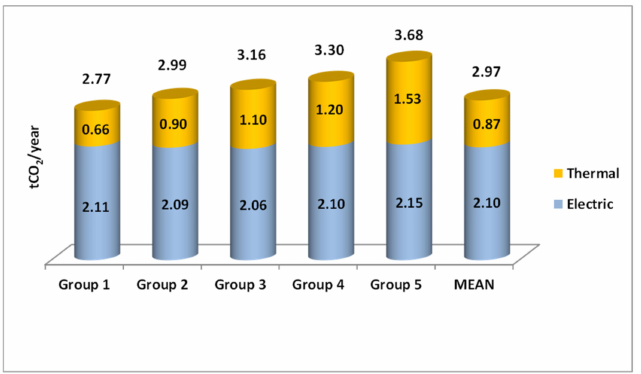
Figure 15. Thermal, electric, and total CO 2 emissions per household by group of cities without the influence of